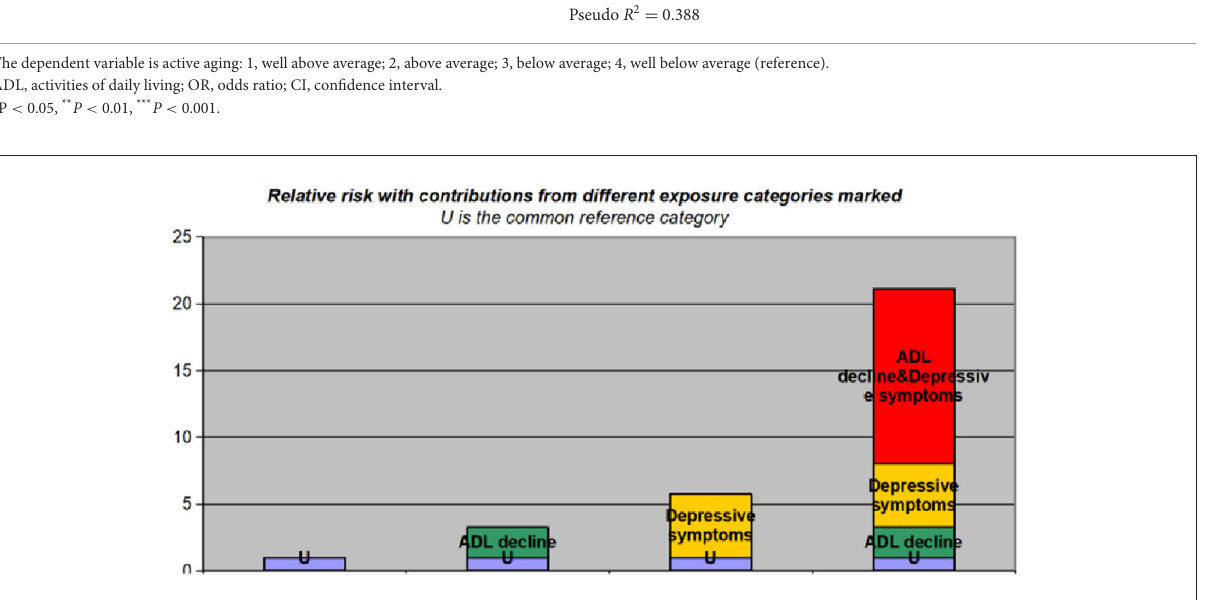
FIGURE3 The odds ratio of well-below-average level active aging with contributions from different exposure categories marked (ADL decline and depressive symptoms). U is the reference category (no ADL decline and no depressive symptoms). ADL, activities of daily